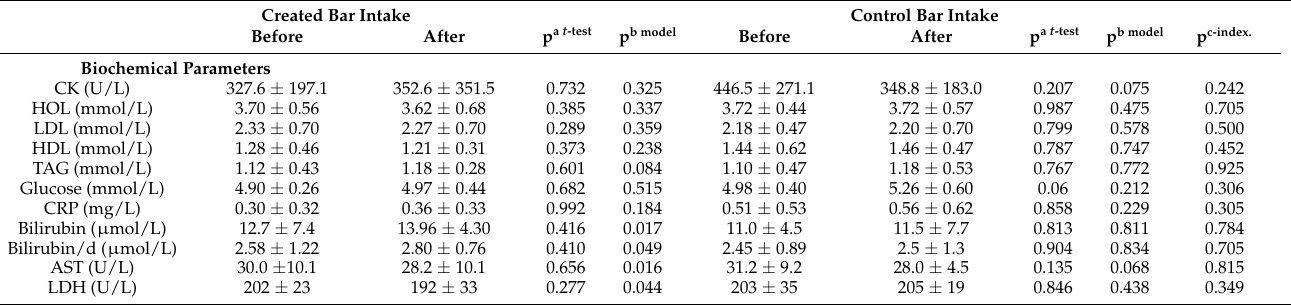
Table 3. Effects of the created and the control bar consumption on the metabolic profile of professional handball payers 1 . Created Bar Intake